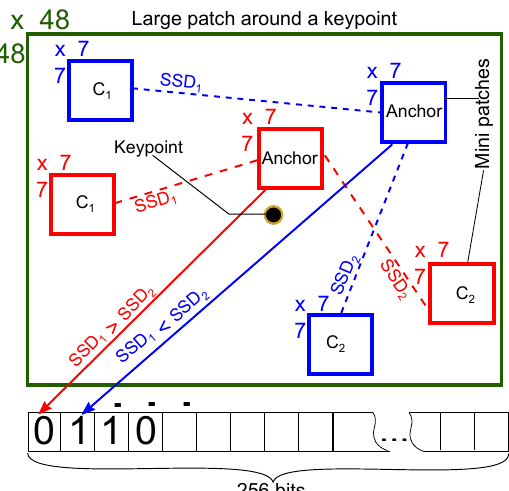
Figure 9. The computation of a particular LATCH descriptor used in this project.